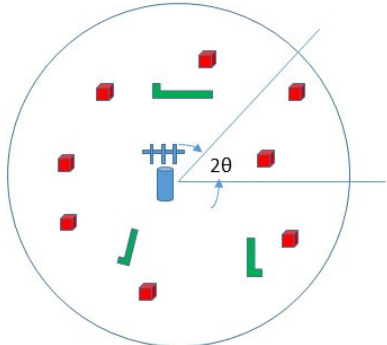
Figure 1. Network topology. Nodes are depicted with boxes (red) and obstacles are depicted with L-shaped schemes